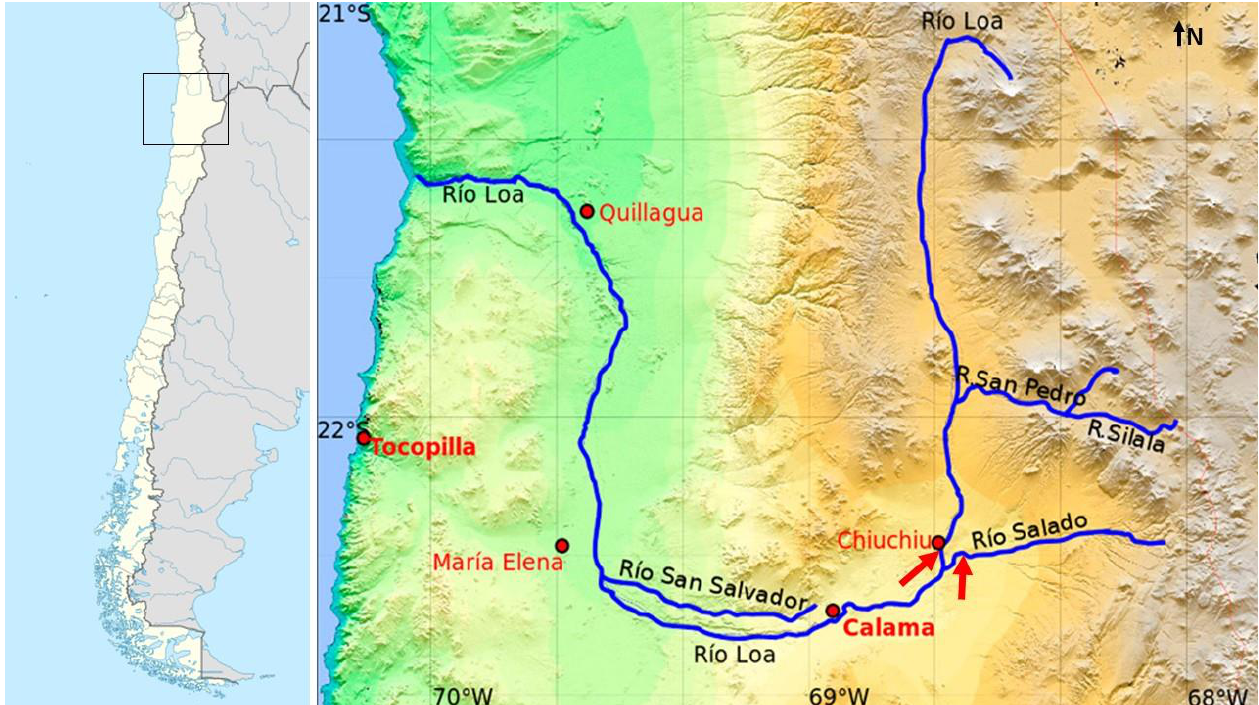
Figure 1. Partial view of the Atacama Desert at the Antofagasta Region, northern Chile. Sites at Loa and Salado rivers selected for sampling sites at pre-Andean corridor (nearly 2500 m above sea level) are shown by red arrows. Images were modified at https://en.wikipedia.org/wiki/Loa_River and https://es.m.wikipedia.org/wiki/Archivo:Chile_location_map.svg (accessed on 12 September 2022) Table 1. Sampling sites, growth, and genus identification of free-living amoebae isolated from Sa- lado and Loa rivers, Region of Antofagasta, northern Chile.